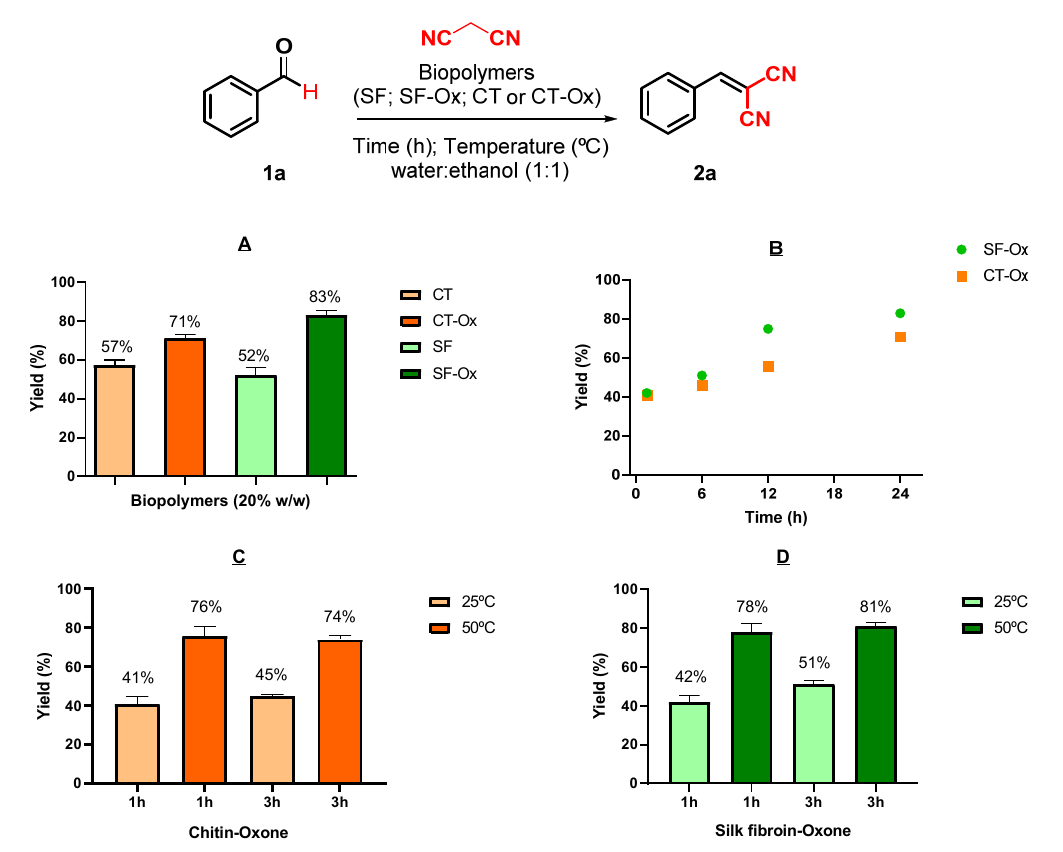
Figure 1. Optimization of Knoevenagel condensation reaction using aldehyde 1a (2 mmol) and malononitrile (2.5 mmol) with and without biopolymers (20% w/w ) as catalysts. ( A ) Screening of biopolymers (rt and 24 h); ( B ) effect of time [1, 3, 6, 12 and 24 h (r.t.)] in presence of CT-Ox and SF-Ox; ( C ) effect of temperature (25 or 50 ◦ C for 1 or 3 h) with CT-Ox; ( D ) effect of temperature (25 or 50 ◦ C at 1 or 3 h) with